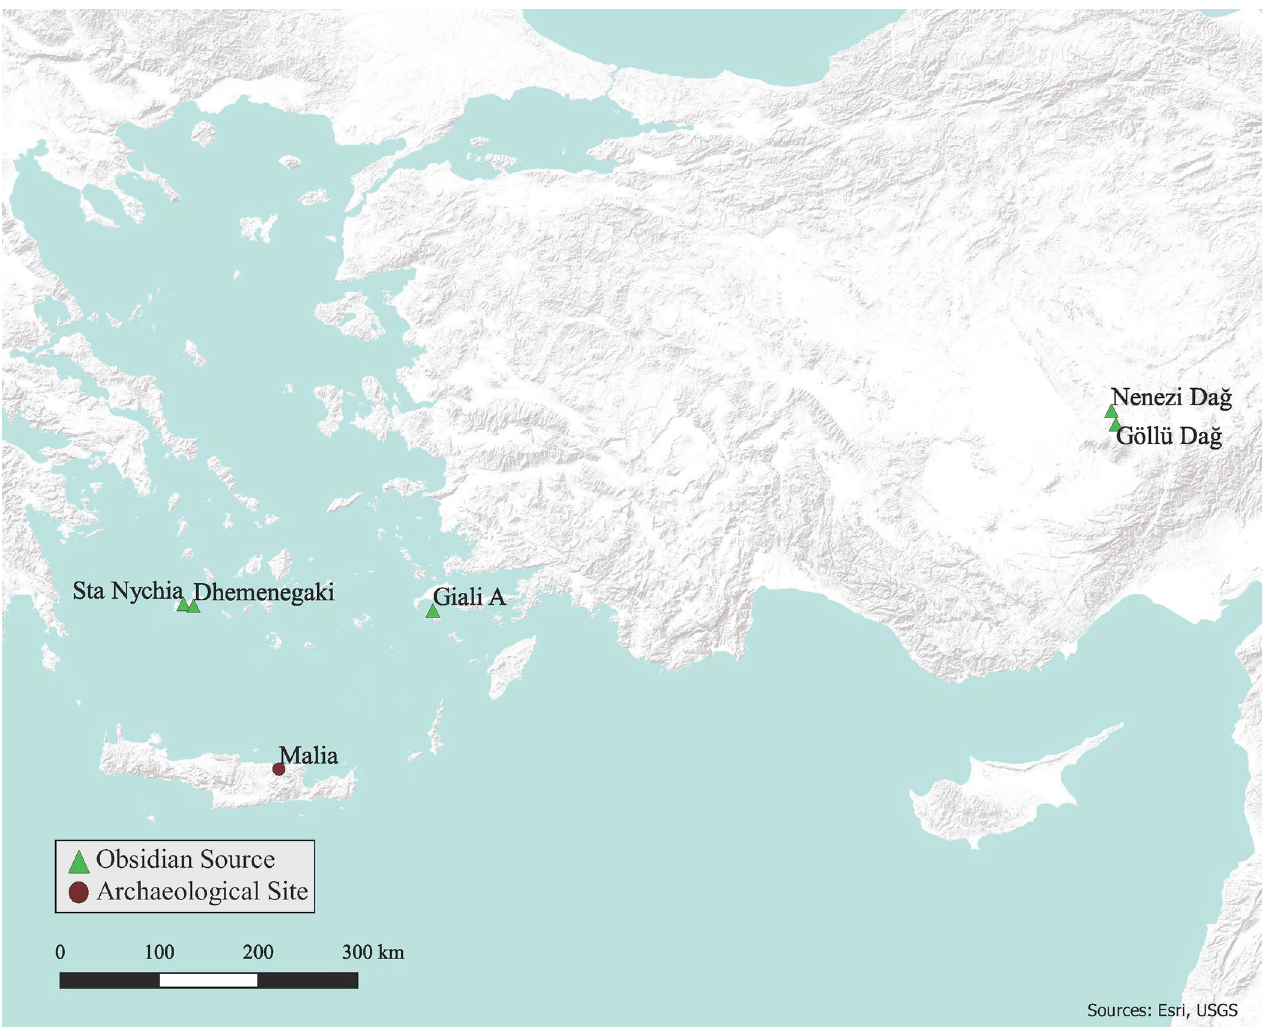
Fig 1. Malia and the obsidian sources detailed in the study. Compiled in QGIS 3.16.3 using ESRI World Terrain base map, by C. Lopez. Original copyright with the